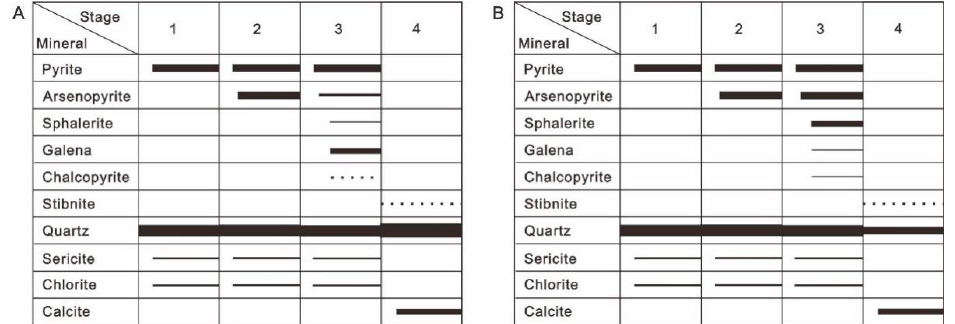
Figure 6. Paragenetic sequences for major minerals of the Hongqigou deposit ( A ) and the Huanglonggou deposit ( B ).